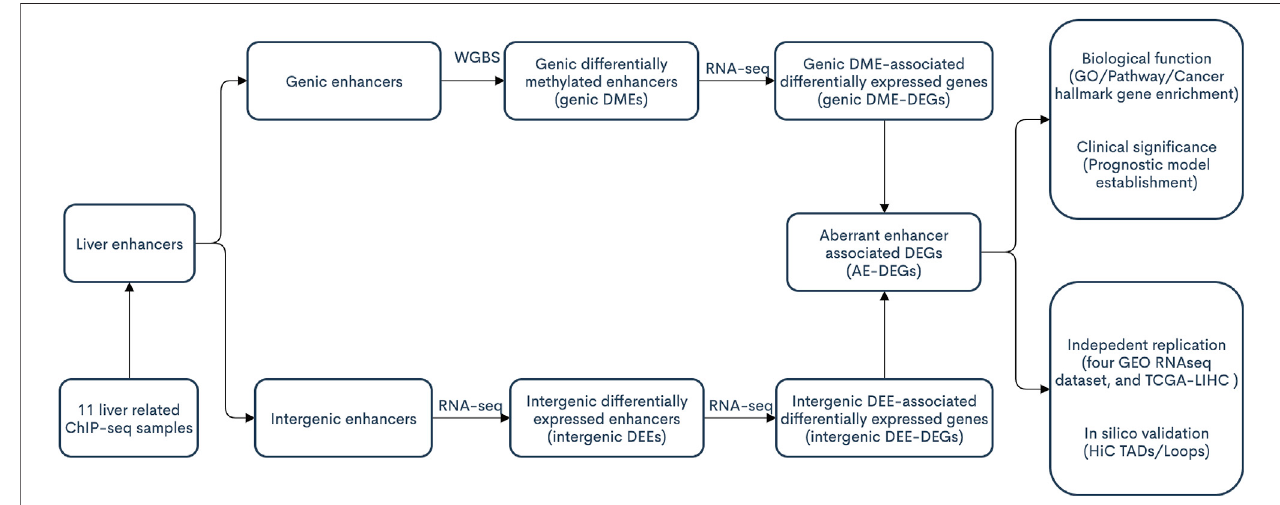
FIGURE 1 | The schematic fl owchart of the present study.